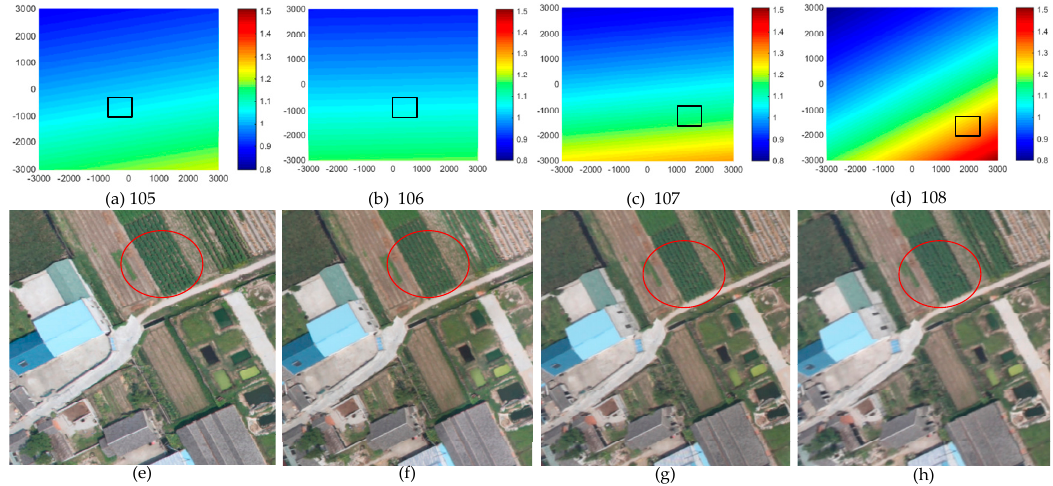
Figure 9. Typical continuous images and schematic diagram of GSD distribution with different (cid:2033) and (cid:2030) angles of Yuyao. ( a ) Schematic diagram of GSD distribution with the angle (cid:2033) and (cid:2030) are 1.7° and 9.5°; ( b ) 0.2° and 9.0°; ( c ) 1.3° and 13°; ( d ) 7.4° and 13.6°; ( e ) Partially view of image “105”; ( f )